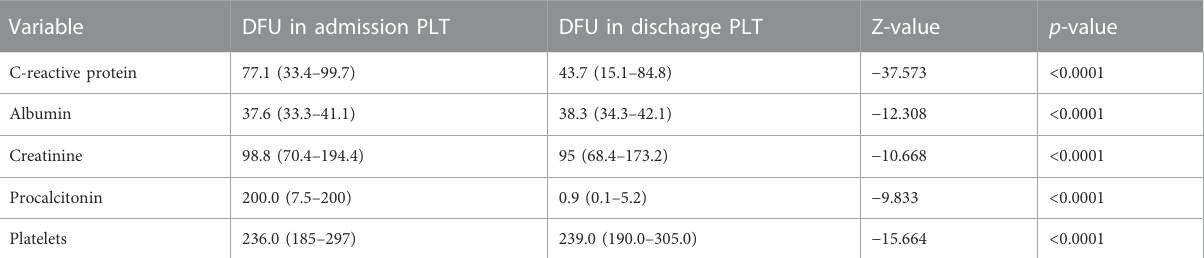
TABLE 6 Signi fi cant difference was observed between admission and discharge in diabetic patients after treatment with NPWT and PRP. * p < 0.05, ** p < 0.01, and *** p < 0.001. PLT: patients of blood parameters, treated with NPWT combined with PRP.